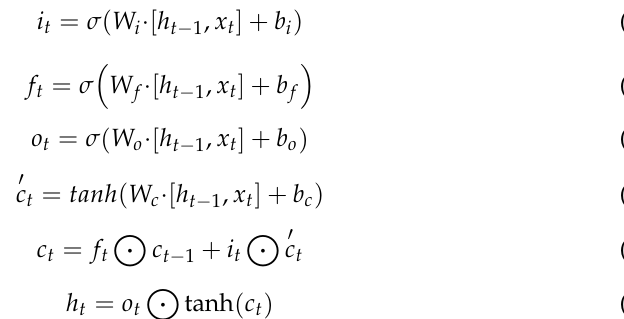
Figure 8. A single block diagram in an RNN-LSTM [41].